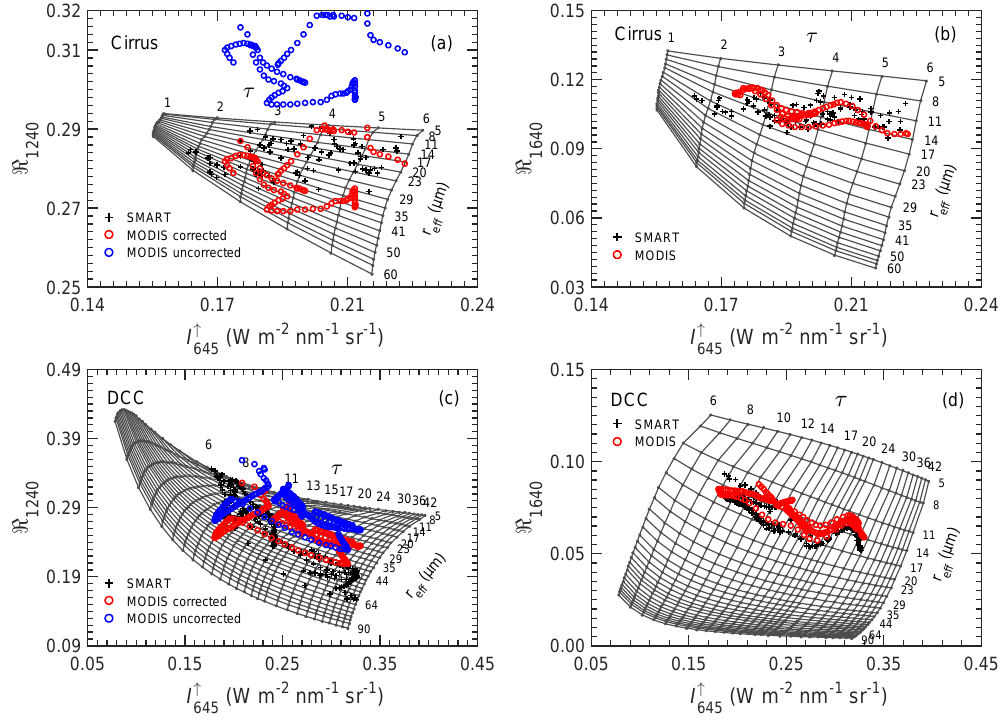
↑ and (cid:60) 1240 ), while (b) 645